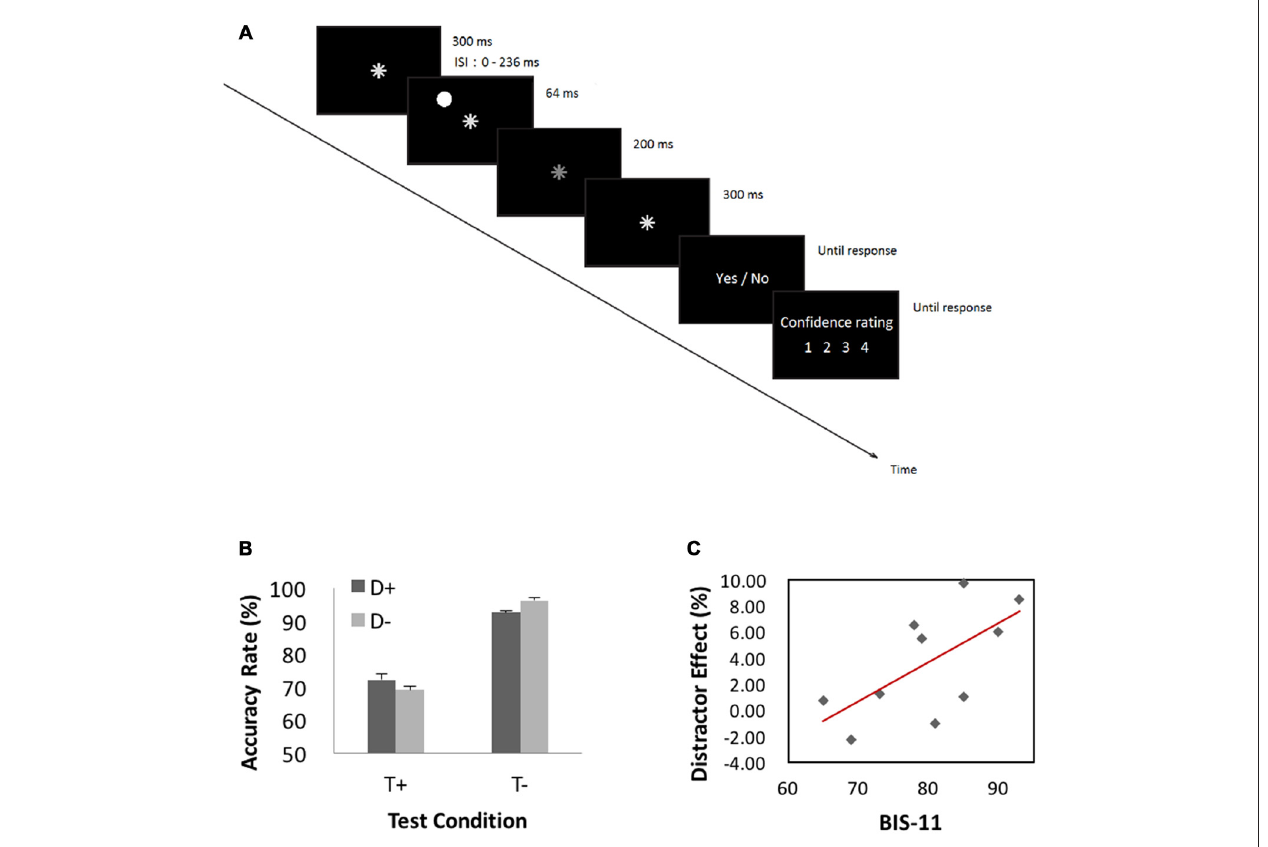
FIGURE 4 | (A) Behavioral paradigm of the attention task. A trial started with presentation of an asterisk for 300 ms at the center of visual display. In half of the trials (target-present trials), the asterisk dimmed for 200 ms randomly between 364 and 600 ms after its onset, and resumed its luminance and stayed on for another 300 ms. The asterisk did not dim in the other half of trials—target-absent trials. In 1/3 of all trials, a “distractor” appeared for 64 ms before asterisk dimming at one of four peripheral locations 6 ◦ from the center (upper left, upper right, lower left and lower right, randomly). A distractor also occurred in target-absent trials with timings matching those of the target-present trials. Participants were instructed to ignore the distractor and responded to the prompt (dimming YES or NO) and rated their confidence level on a scale from 1 (not confident at all) to 4 (very confident). (B) Performance results. A repeated measures ANOVA on accuracy rate showed a significant main effect of target condition with higher accuracy for target-absent than target-present trials. (C) Correlation with BIS-11 score. We quantified the influence of distractor by subtracting the accuracy rate of distractor-present from that of distractor-absent, each for target-present and target-absent trials. This distractor effect was significantly correlated with BIS-11 score for target-absent but not target-present